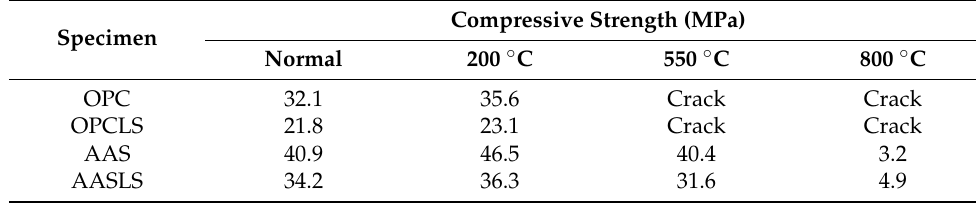
Table 6. Effects of different hydration processes on high-temperature